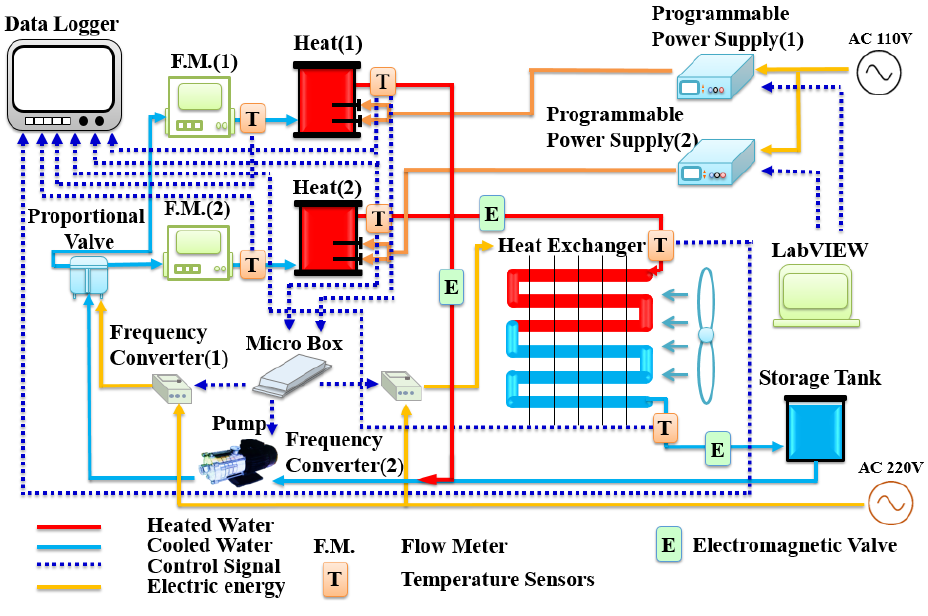
Figure 5. Hardware designs of the IHTMS. Table 1. Specifications of key components.